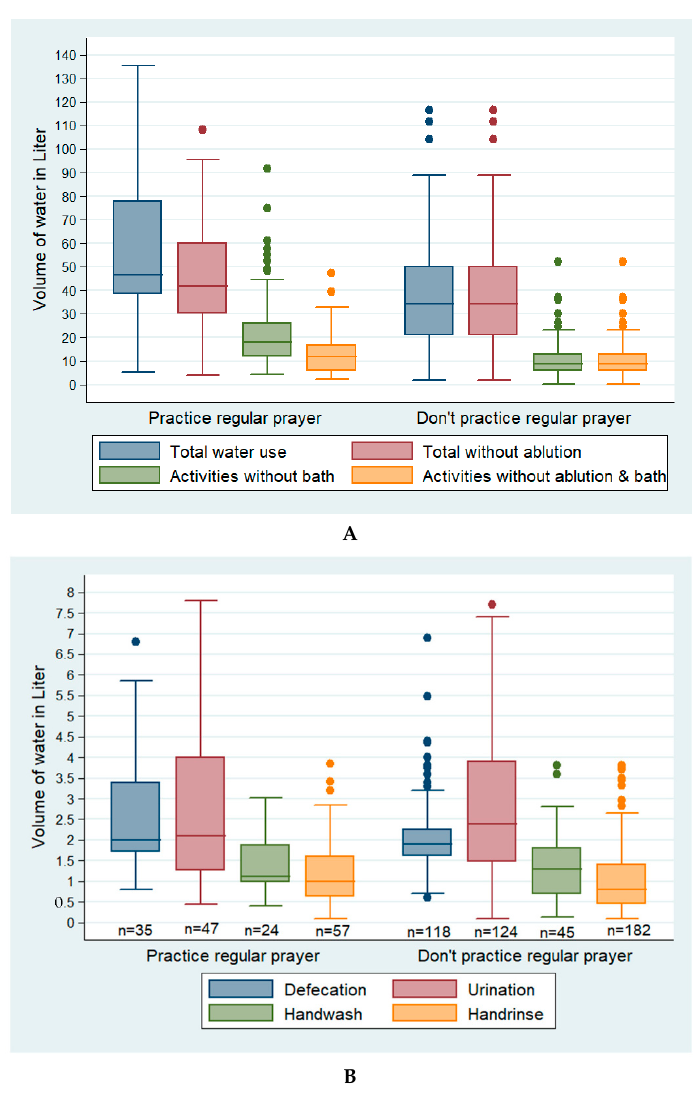
Figure 2. The differences between the water use of participants who practiced religious prayer regularly and the water use of those who did not practice religious prayers regularly among the low-income urban residents of Arichpur, Dhaka, from May 2015 to March 2016: ( A ) the personal hygiene practices of participants who prayed regularly ( n = 61) and those who did not ( n = 201); ( B ) the personal hygiene practices of participants who prayed regularly ( n = 61) and those who did not ( n = 201).